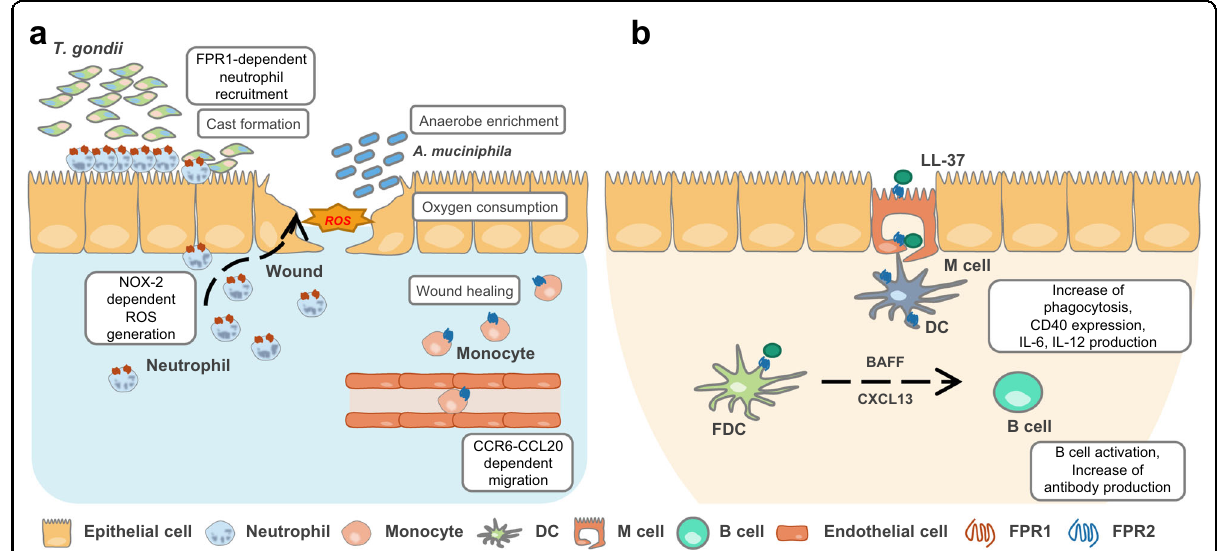
Fig. 1 Functional roles of FPRs in the regulation of immune responses in the GI tract. a Neutrophils migrate into the in fl amed GI tract toward various chemoattractants. In the case of Toxoplasma gondii and bacterial infection, neutrophils migrate to the gut lumen in an FPR1-dependent manner to regulate bacterial containment and to separate luminal contents from the epithelium. Neutrophils activated by FPR1 remove microenvironmental oxygen by NOX2-mediated ROS generation, resulting in local enrichment of an anaerobic bacterial consortium. In particular, Akkermansia muciniphila facilitates epithelial wound healing through an epithelial NOX1-dependent mechanism. Monocytes, which facilitate epithelial remodeling during wound closure, migrate into the in fl amed site via the CCL20-CCR6 axis. FPR2 expression is related to the expression of CCR6 in monocytes. b M cells and DCs in Peyer ’ s patches recognize LL-37 via FPR2, promoting DC activation with increased phagocytosis, expression of CD40, and production of IL-6 and IL-12. Follicular DCs express CXCL13 and B cell-activating factor, supporting germinal center B cell activation in Peyer ’ s patches via FPR2